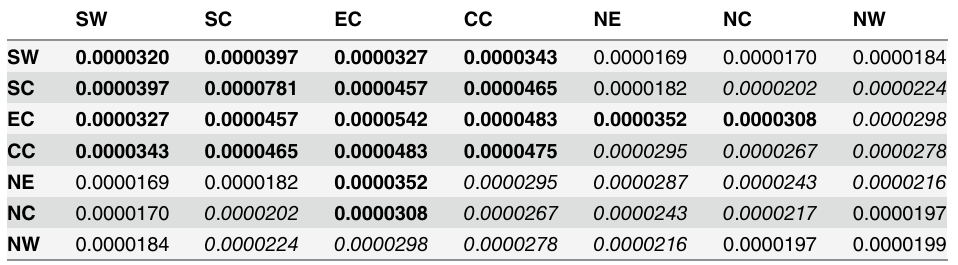
Table 6. HLA Matching within and between populations from each of the seven regions of China (matching rates).